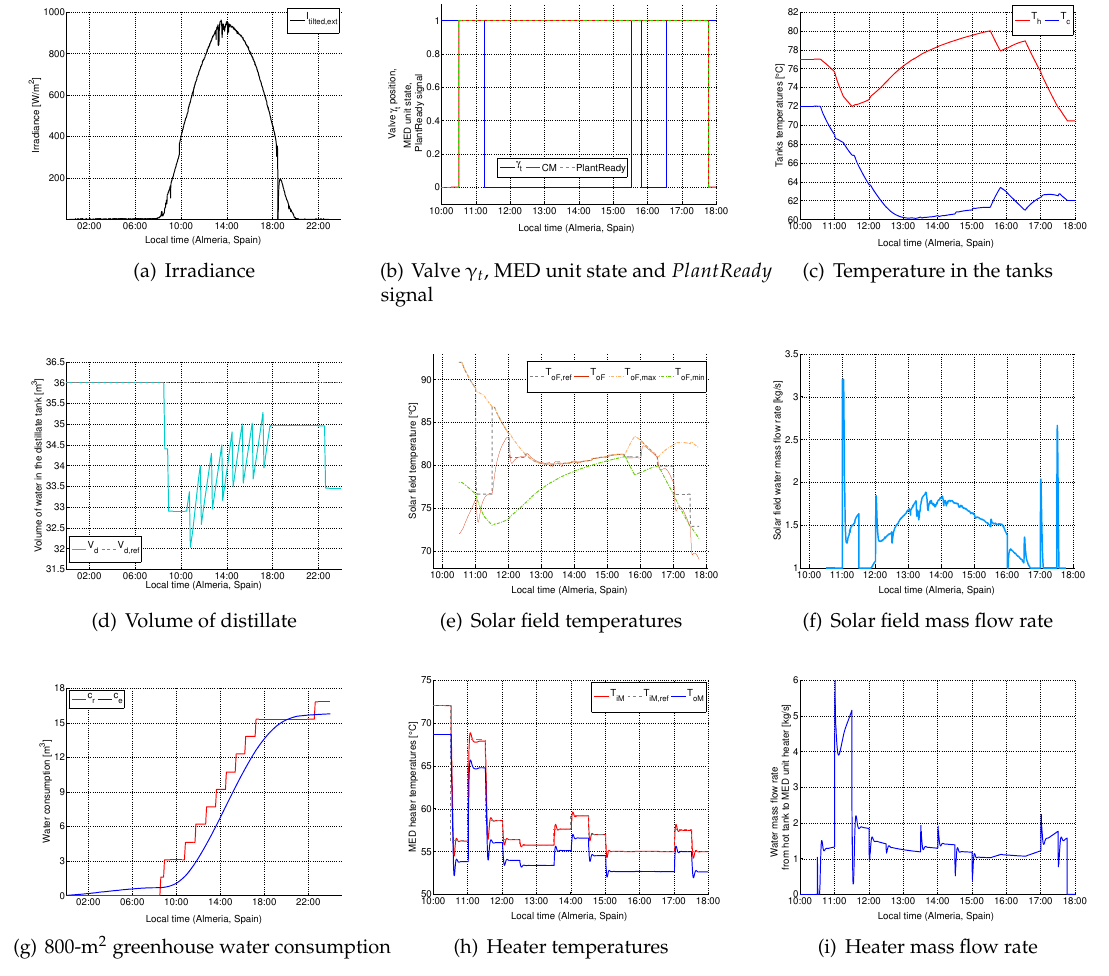
Figure 7. Simulation results obtained for a sunny day. ( a ) Irradiance; ( b) Valve γ t , MED unit state and PlantReady ; ( c ) Temperature in the tanks; ( d ) Volume of distillate; ( e ) Solar field temperatures; ( f ) Solar field mass flow rate; ( g ) 800-m 2 greenhouse water consumption; ( h ) Heater temperatures; ( i ) Heater mass flow